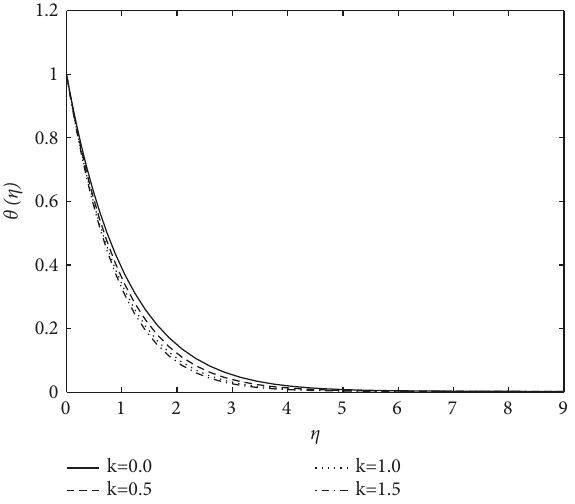
Figure 7: Change in the value of θ ( η ) for different values of.